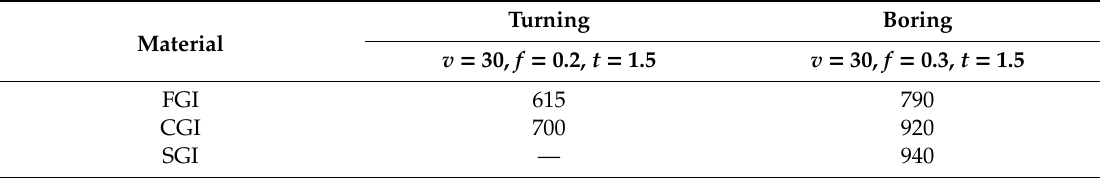
Table 7. The average cutting force, N [3].